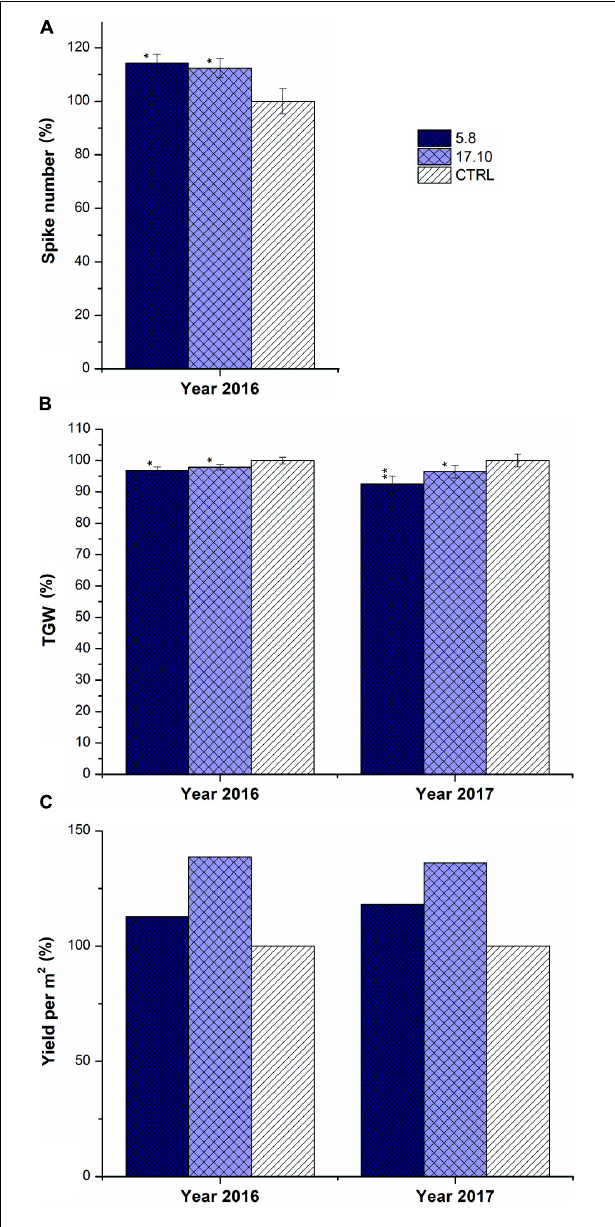
FIGURE 8 | Yield parameters of KD-CKX1 lines grown under field conditions. Spike number per plant (A) , TGW (B) and yield per m 2 (C) were established in KD-CKX1 lines (5.8 and 17.10) and control plants (CTRL) in 2016 and 2017. Data are expressed as percentage (%) of the value obtained for CTRL, which was set up to 100%. Values are mean ± SE ( n = 50). A non-parametric Kruskal–Wallis Anova & Median test analysis was performed followed by a post hoc multiple comparison of mean rank (Statistica v. 13.3); ∗ p < 0.01, ∗∗ p < 0.001.